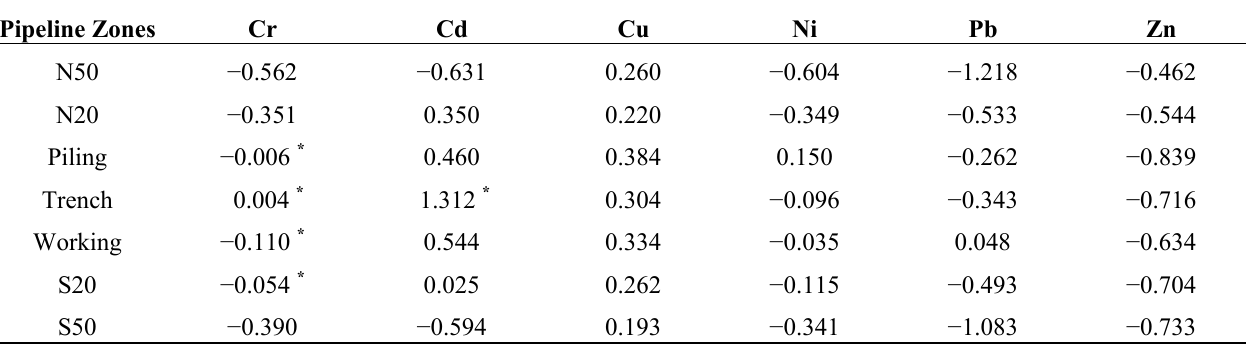
Table 5. Index of geo-accumulation in Xi’an (Site